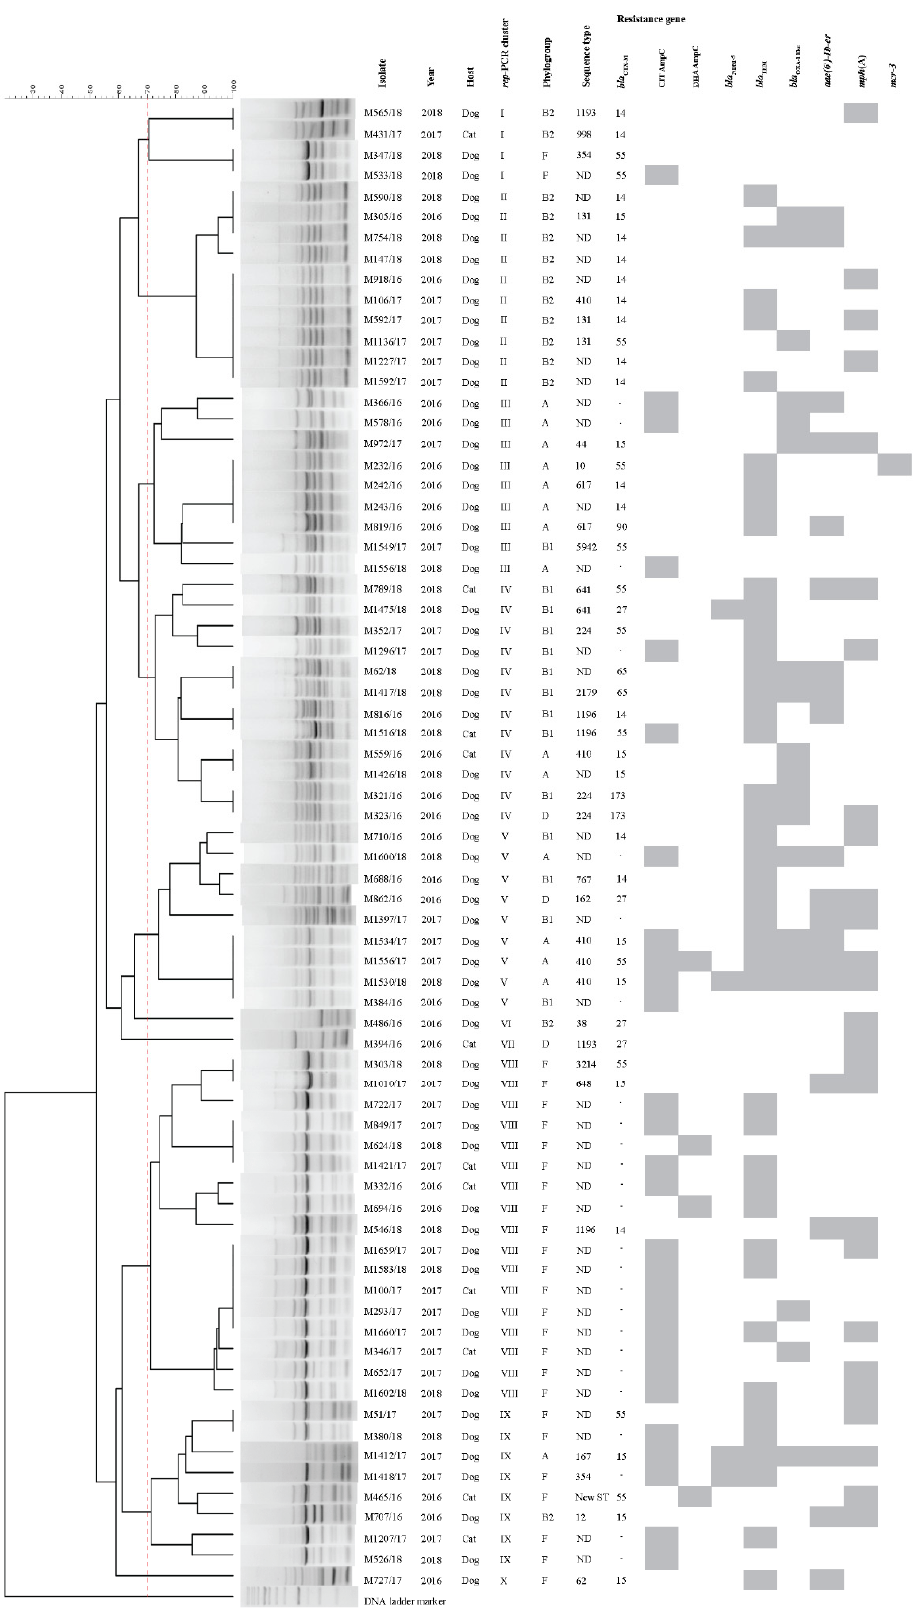
Figure 1. Antimicrobial resistance genes and genetic features based on repetitive extragenic palindromic sequence-PCR ( rep - PCR), phylogroup and sequence type of 60 canine and 12 feline extended-spectrum cephalosporin-resistant uropathogenic Escherichia coli in Thailand,